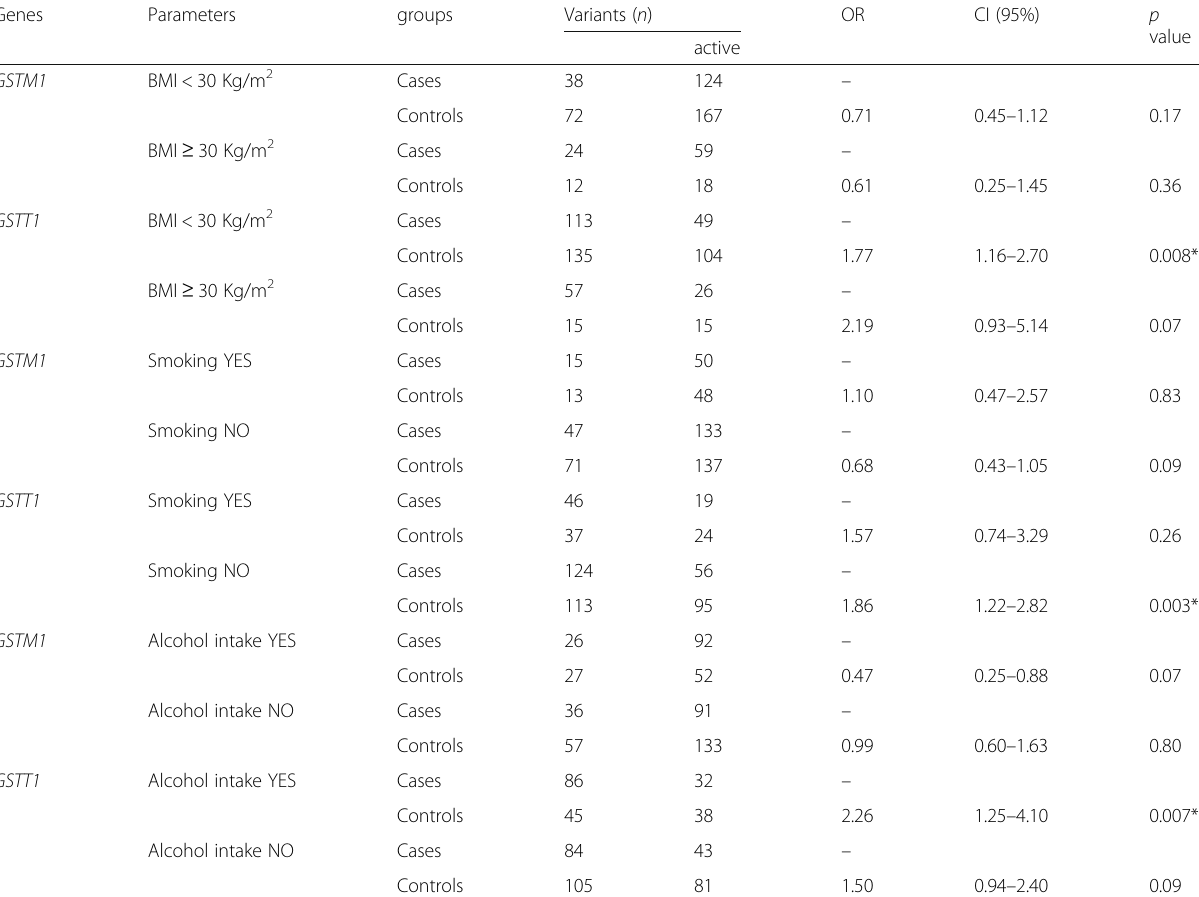
Table 4 BMI, age, and sex stratified analysis of association between GSTM1 and GSTT1 variants with essential hypertension